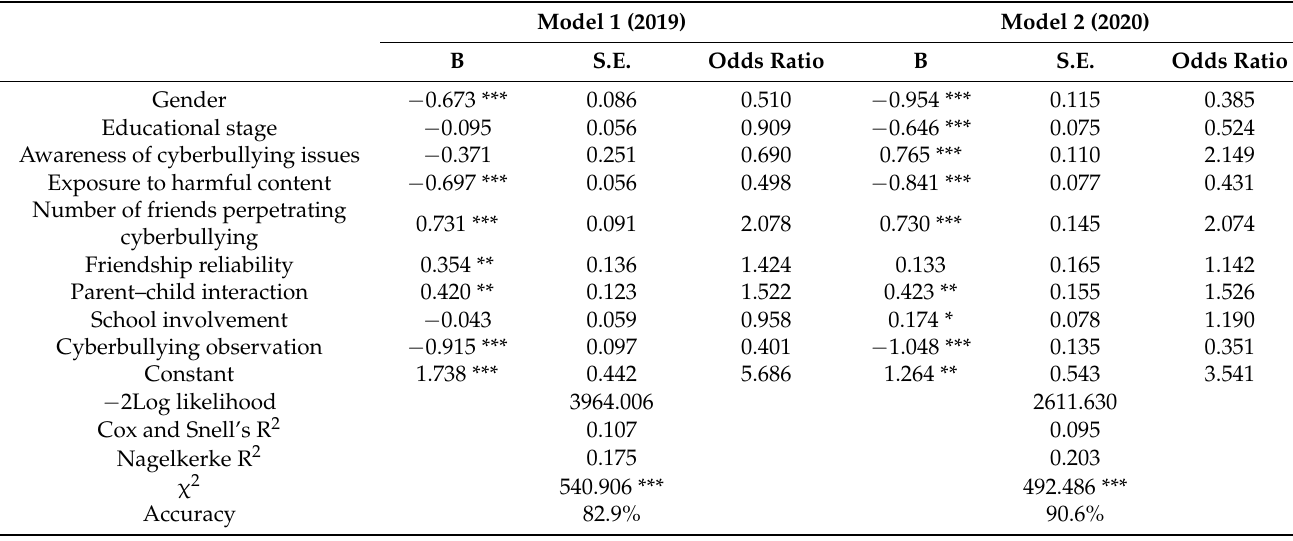
Table 6. Factors affecting experiences in cyberbullying perpetration before and after COVID-19